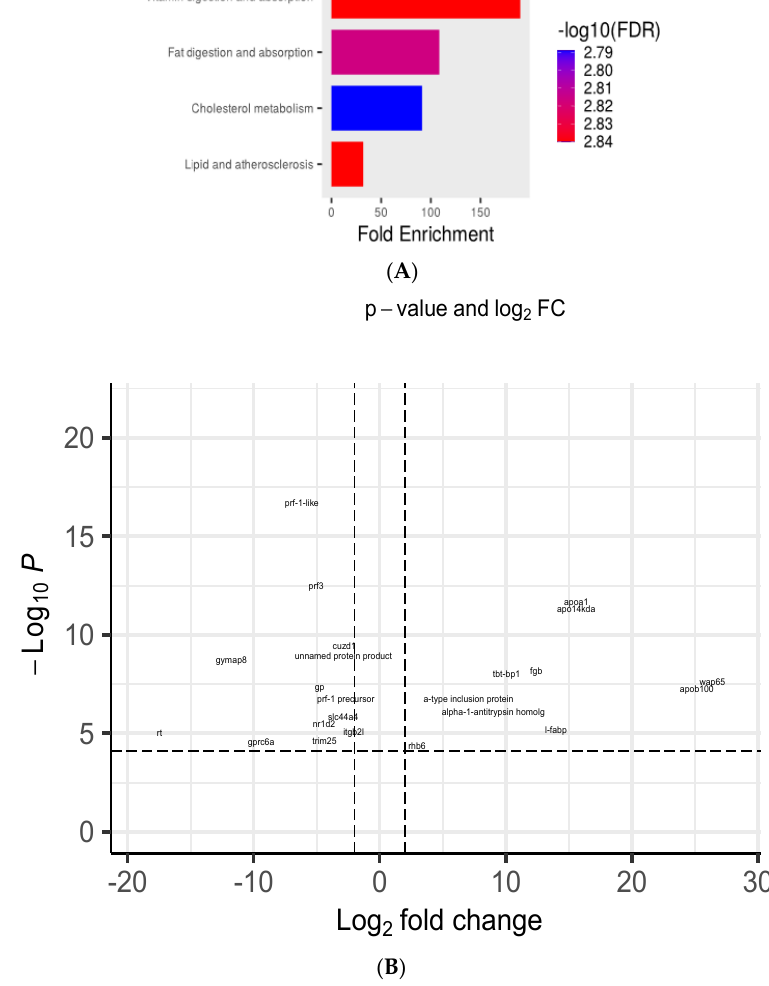
Figure 8. ( A ) Bar chart of − log10 of signi fi cantly enriched pathways. ( B ) Volcano plots showing signi fi cant genes between the normal individuals and the deformed individuals. Each point in the plots represents a gene, with its log2 fold change (FC) in the x -axis and its − log10 p -value in the y -axis. Positive fold change means upregulated in deformed samples. Only genes with an adjusted p -value < 0.05 and log2 fold change between − 2 and 2 are shown.